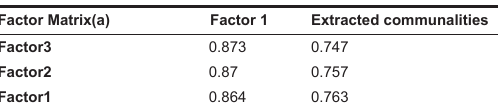
TABLE 7 Factor loadings and communalities